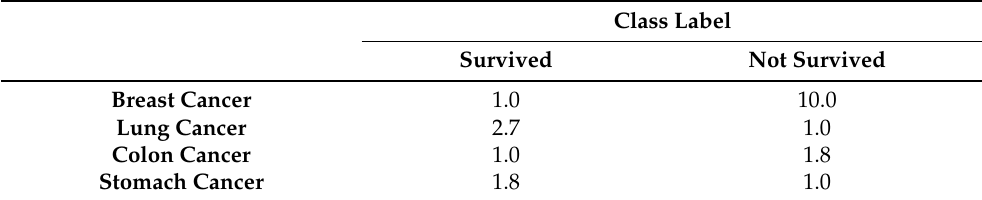
Table 3. The misclassification